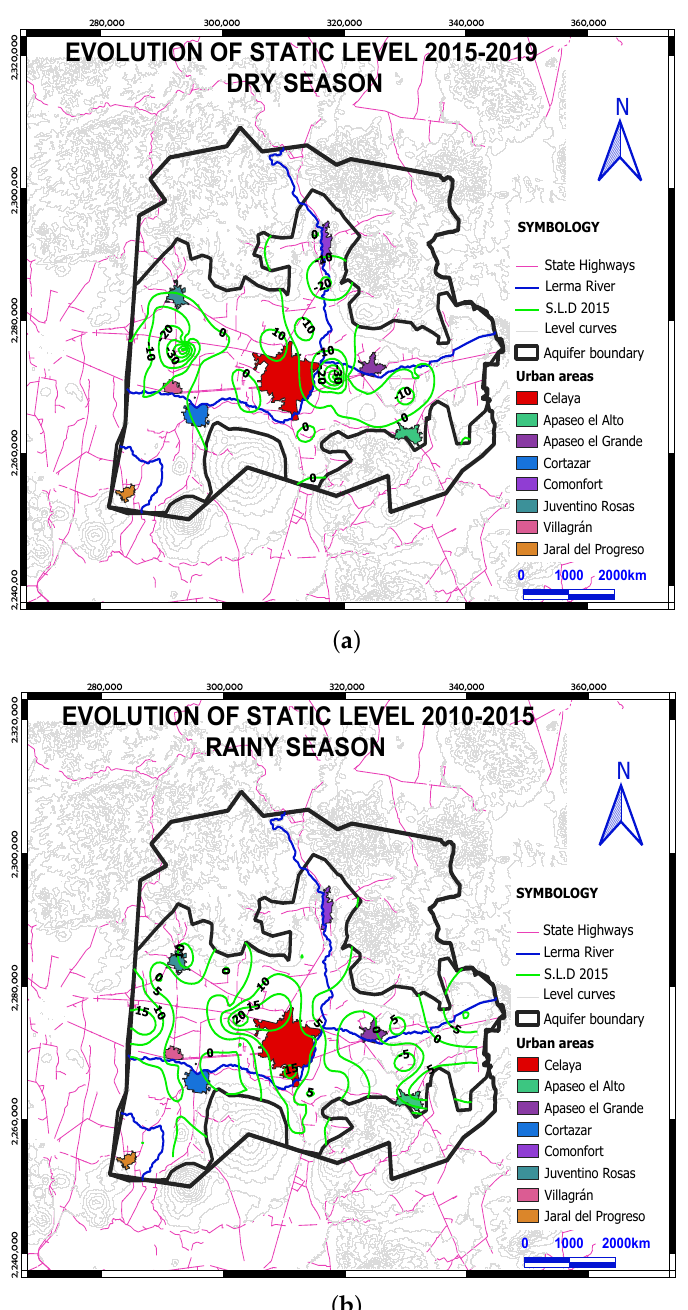
Figura 1.20: Temporada de Lluvias: Evoluci´on del nivel est´atico 2010 Figure 8. Static level evolution. ( a ) Analysis period of 2015 to 2019 in dry season. ( b ) Analysis period of 2010 to 2015 in rainy